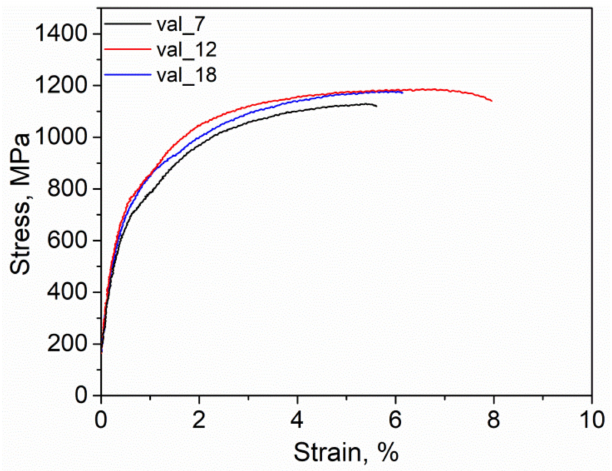
Figure 6. Stress-strain curves produced for the experimental validation of the proposed optimization program (run 7, 12 and 18).